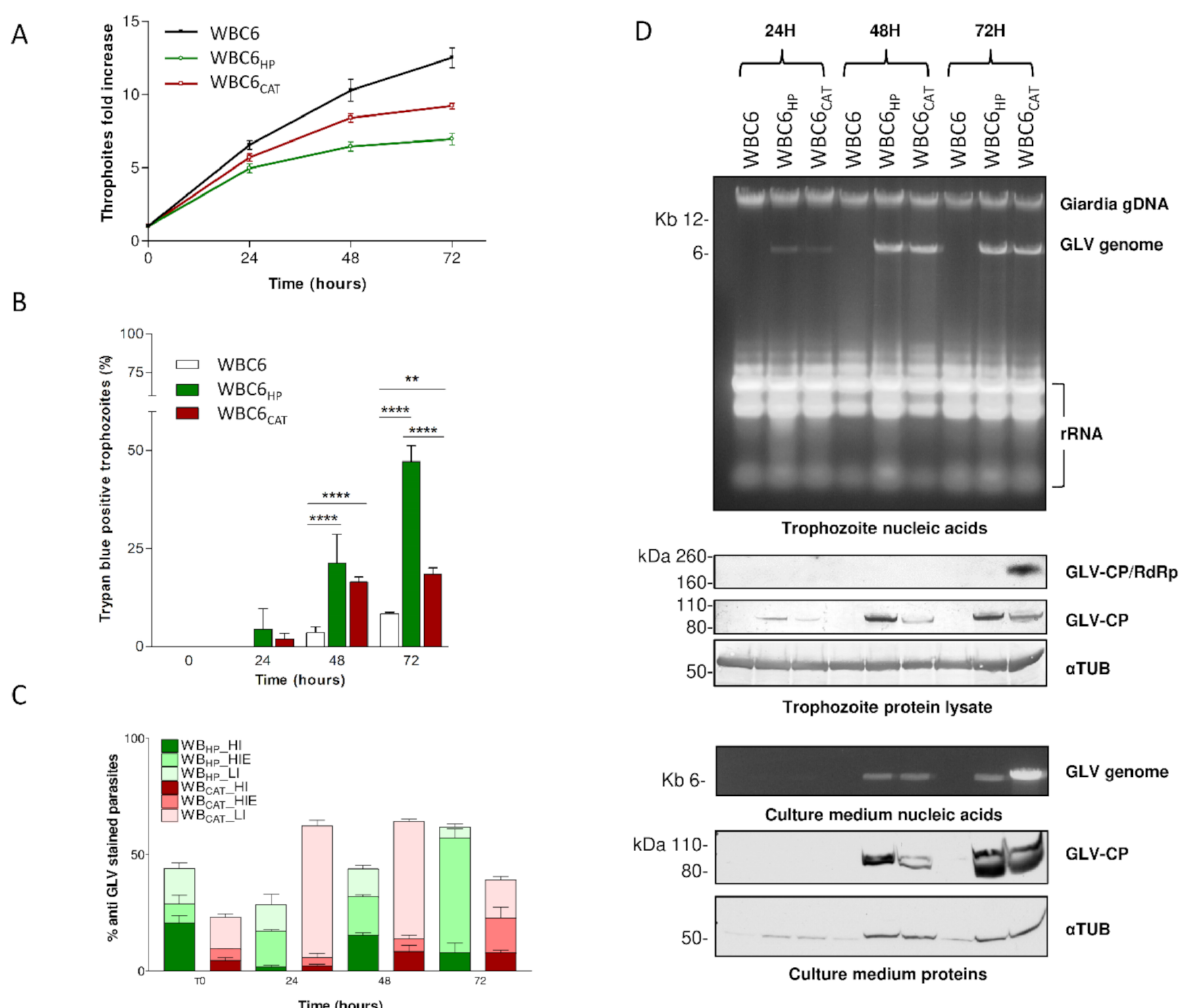
Figure 7. Time course of GLV infection in constitutively WBC6 HP and WBC6 CAT trophozoites. ( A ) Growth curve of naïve G. duodenalis WBC6 isolate ( (cid:4) ), WBC6 HP strain ( ) and WBC6 CAT strain ( (cid:3) ). WBC6 HP and WBC6 CAT trophozoites (cid:35) constitutively infected with GLV (after 12 passages from infection) were used. Experiment was conducted in triplicate. Parasite were counted in hemocytometer every 24 h, as reported in Materials and Methods section. ( B ) Percentage of trypan blue positive trophozoites counted throughout the parasites growth curve. ** p < 0.01; **** p < 0.0001. ( C ) Percentage of WBC6 HP and WBC6 CAT trophozoites showing or not staining for the rabbit anti-g14-3-3 polyclonal antibody and/or the mouse anti GLV-CP_NT polyclonal serum by immunofluorescence analysis throughout parasites growth curve. Parasites were classified based on staining as follows (see main text for details): HIE, highly infected but empty, with strong GLV signal but faint or absent staining with for 14-3-3; HI, highly infected, with strong signal for both GLV and 14-3-3; LI, low infected, with faint or spotted GLV signals and strong staining for 14-3-3. ( D ) Total nucleic acids analysis by agarose gel electrophoresis (0.8%) and protein expression analysis by SDS-PAGE (4–12%) and immunoblot throughout parasites growth curve. Equal amount of trophozoites (2 × 10 6 ) and ultracentrifuged culture medium (3 mL) were processed to extract either the total nucleic acids or the total proteins, as described in Materials and Methods. For the nucleic acids analysis, bands corresponding to G. duodenalis genomic DNA (gDNA), GLV genome and ribosomal RNA (rRNA) are indicated. Nucleic acids’ molecular sizes (in kilobases, Kb) are reported on the left. Immunoblot analysis was performed with the mouse anti-GLV-CP_NT and mouse anti- α -Tubulin. Bands corresponding to the CP/RdRP, the CP and α -Tubulin are indicated. Protein molecular sizes (in Kilo Dalton, kDa) are reported on the